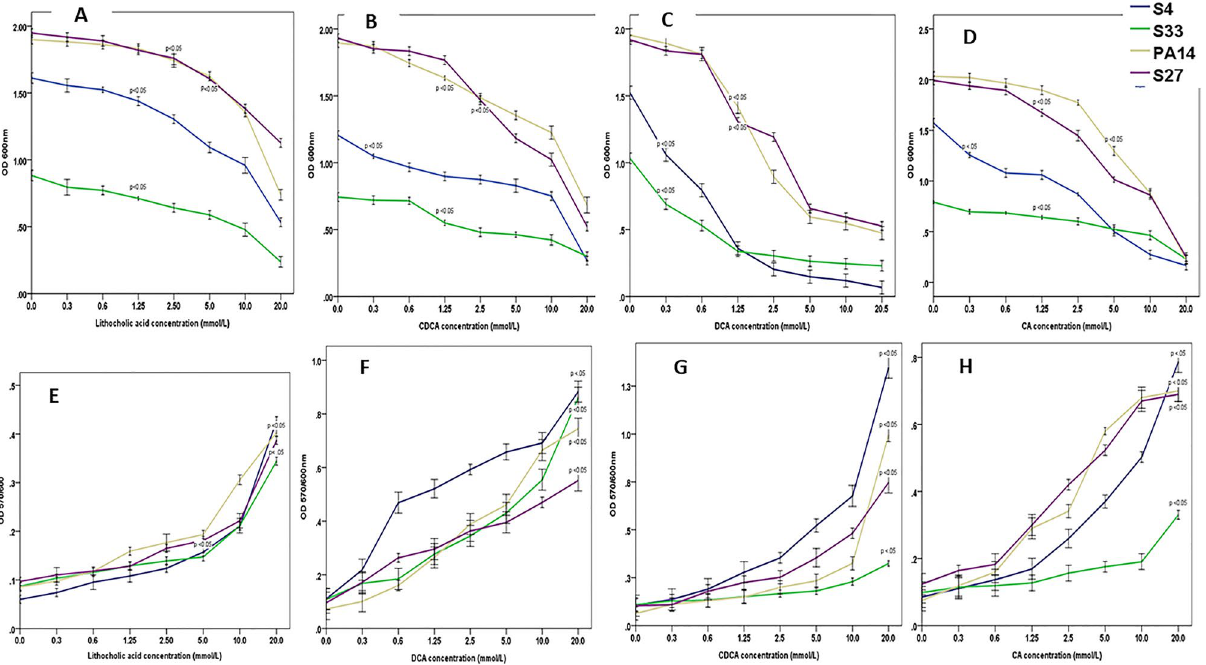
Figure 3. The Impact of different bile acids at concentrations range 0.3 mmol/l to 20mmmol/l (x-axis) (resembling the concentration of bile acid at gastric juice in normal healthy individual on Pa growth ( A–D ) and biofilm formation ( E–H ) ( OD optical